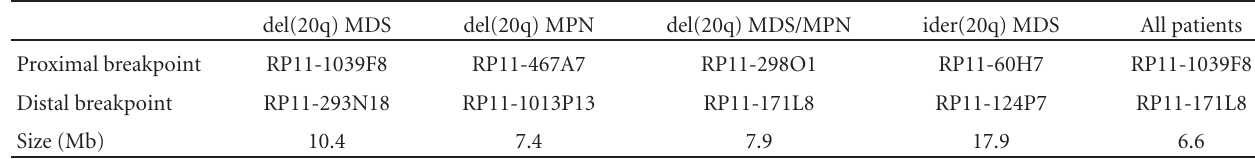
) and retained ( ) regions of (cid:0) (cid:2)